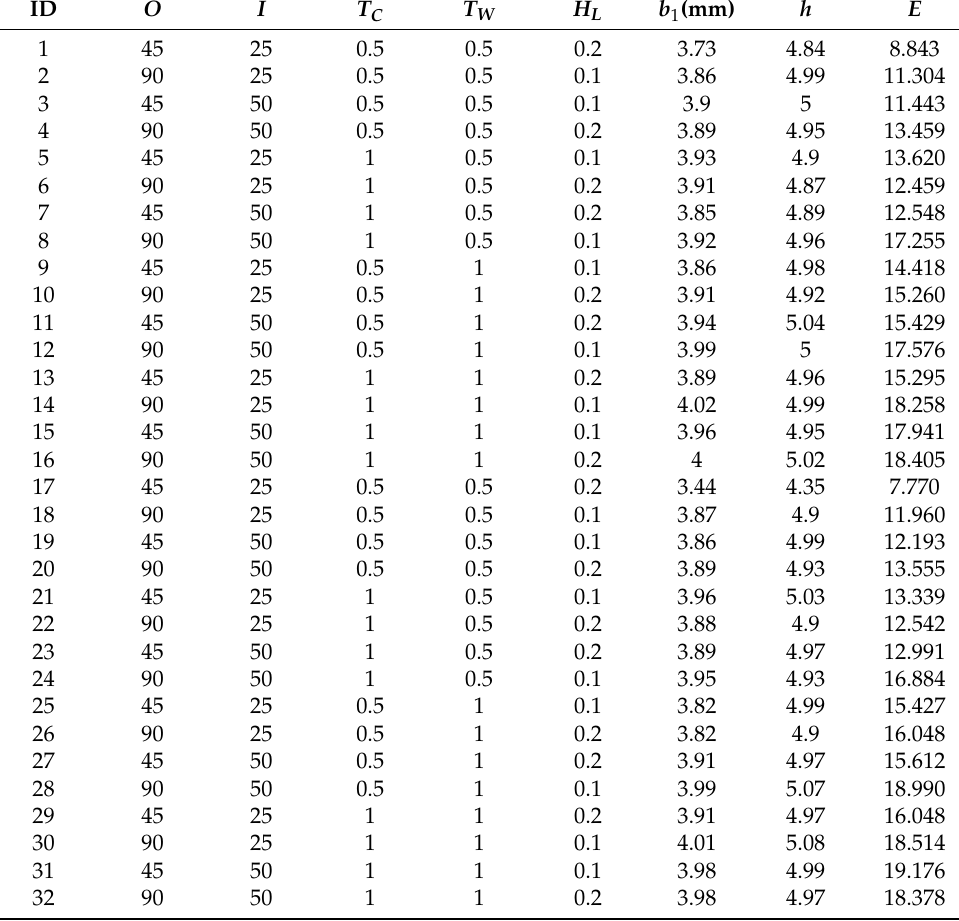
Table 5. E ( 10 ) and dimensional measures for test specimens in